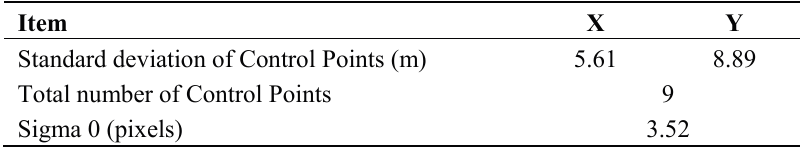
Table 1. The interior accuracy of historical aerial images.